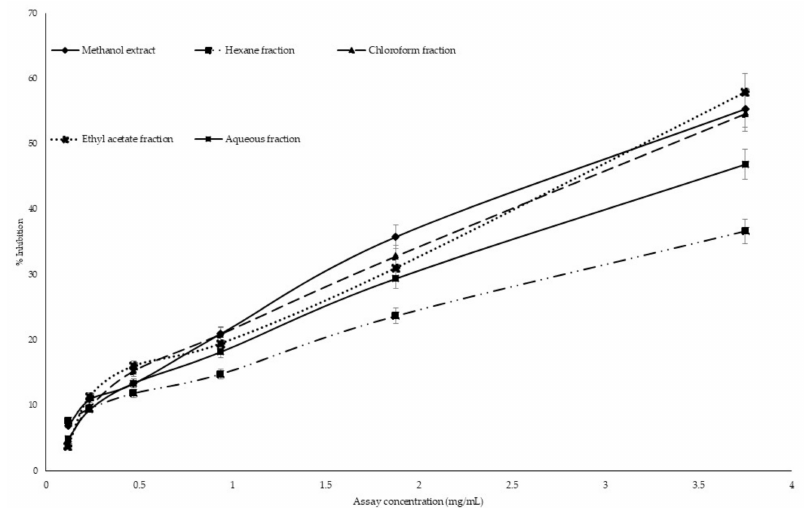
Figure A1. Dose dependent DPPH (1, 1-diphenyl-2-picrylhydrazine) radical scavenging activity of methanol extract and fractions of Gracillaria edulis. Data presented as mean ± standard deviation ( n =